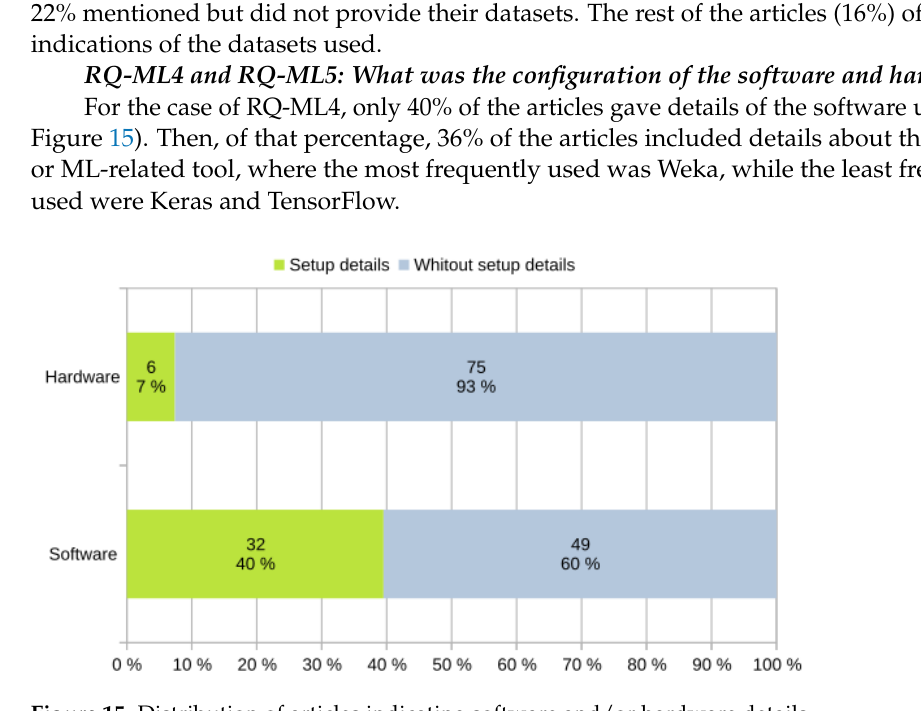
Figure 15. Distribution of articles indicating software and/or hardware details.